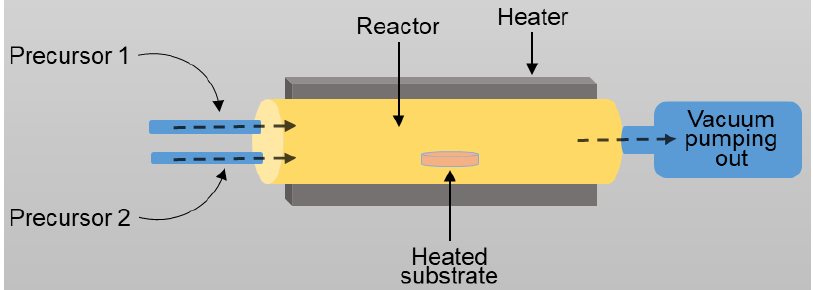
Figure 5. The schematics of the ALD system.